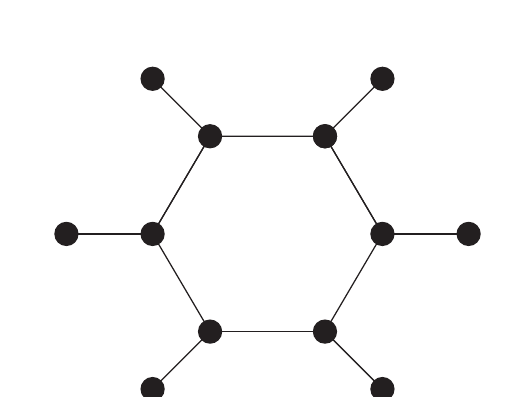
Figure 6: Thorn ring, C